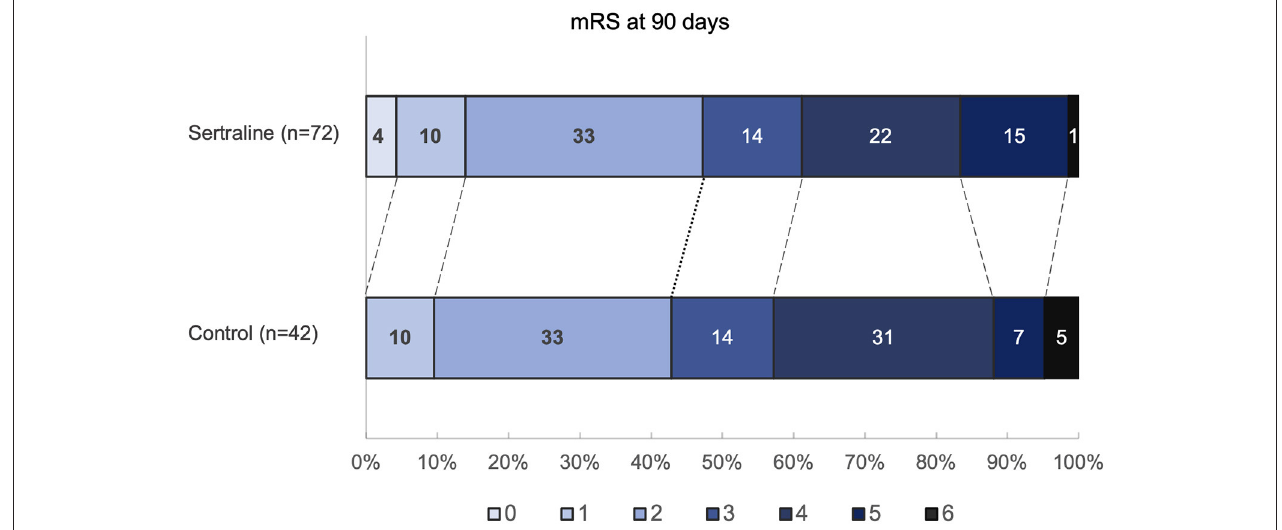
FIGURE 2 | Distribution of mRS scores at 90 days. Values within each colored region correspond to the percentage of patients with the corresponding mRS outcome. mRS indicates modified Rankin Scale.